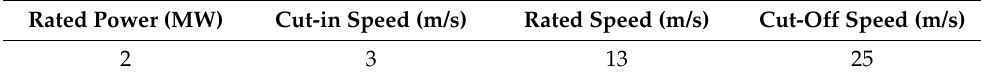
Table 8. Wind turbines